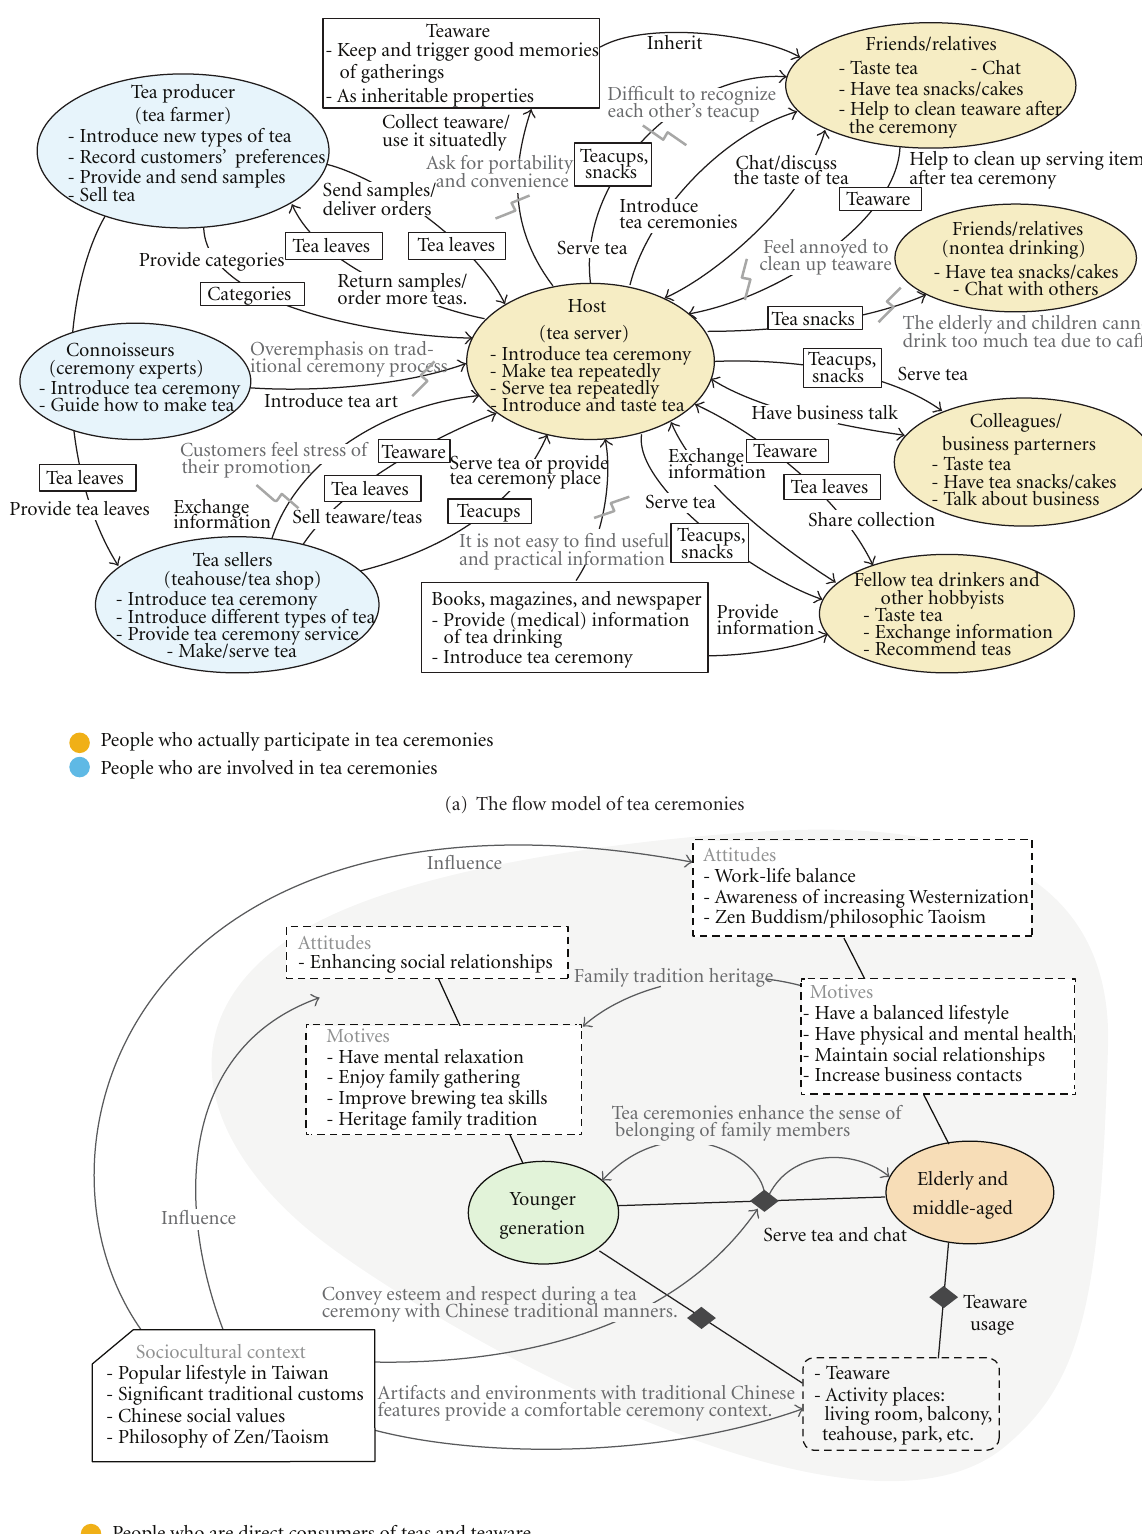
Figure 1: Di ff erent user types in tea